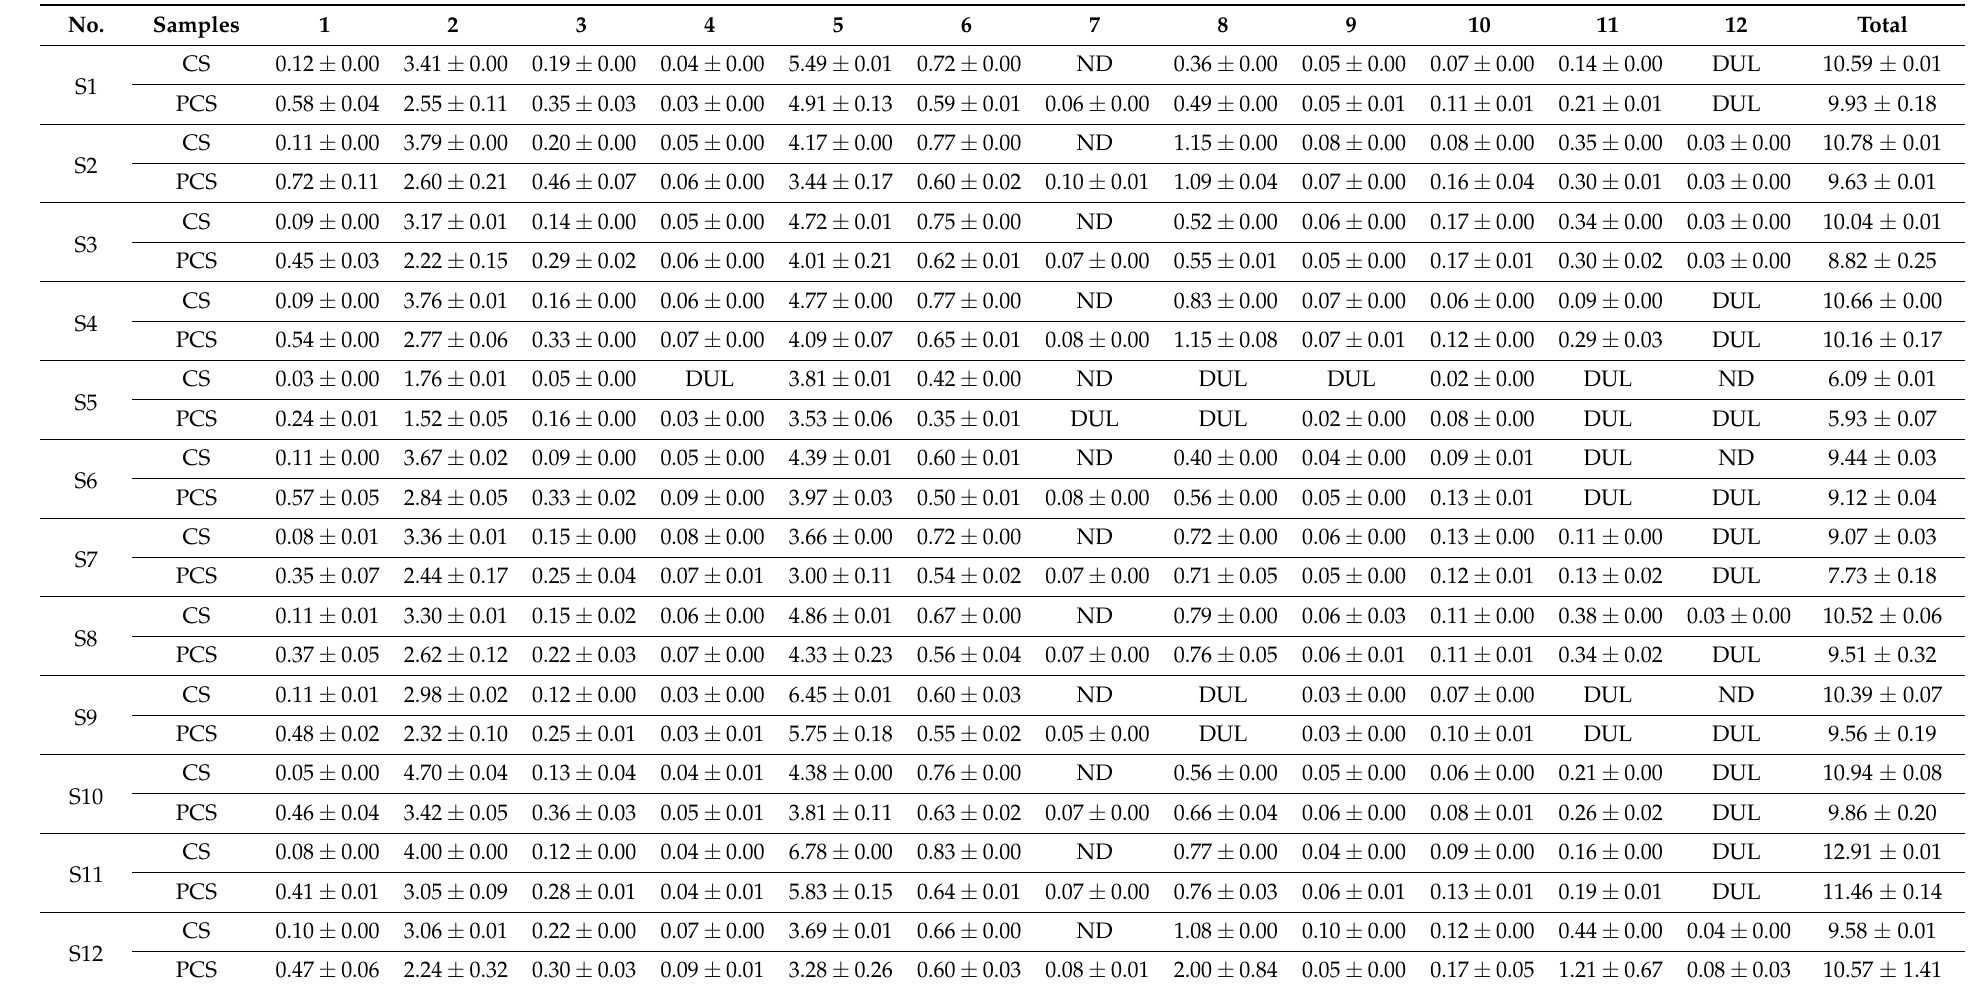
Table 3. The contents of the 12 components in the 21 batches of CS and PCS samples